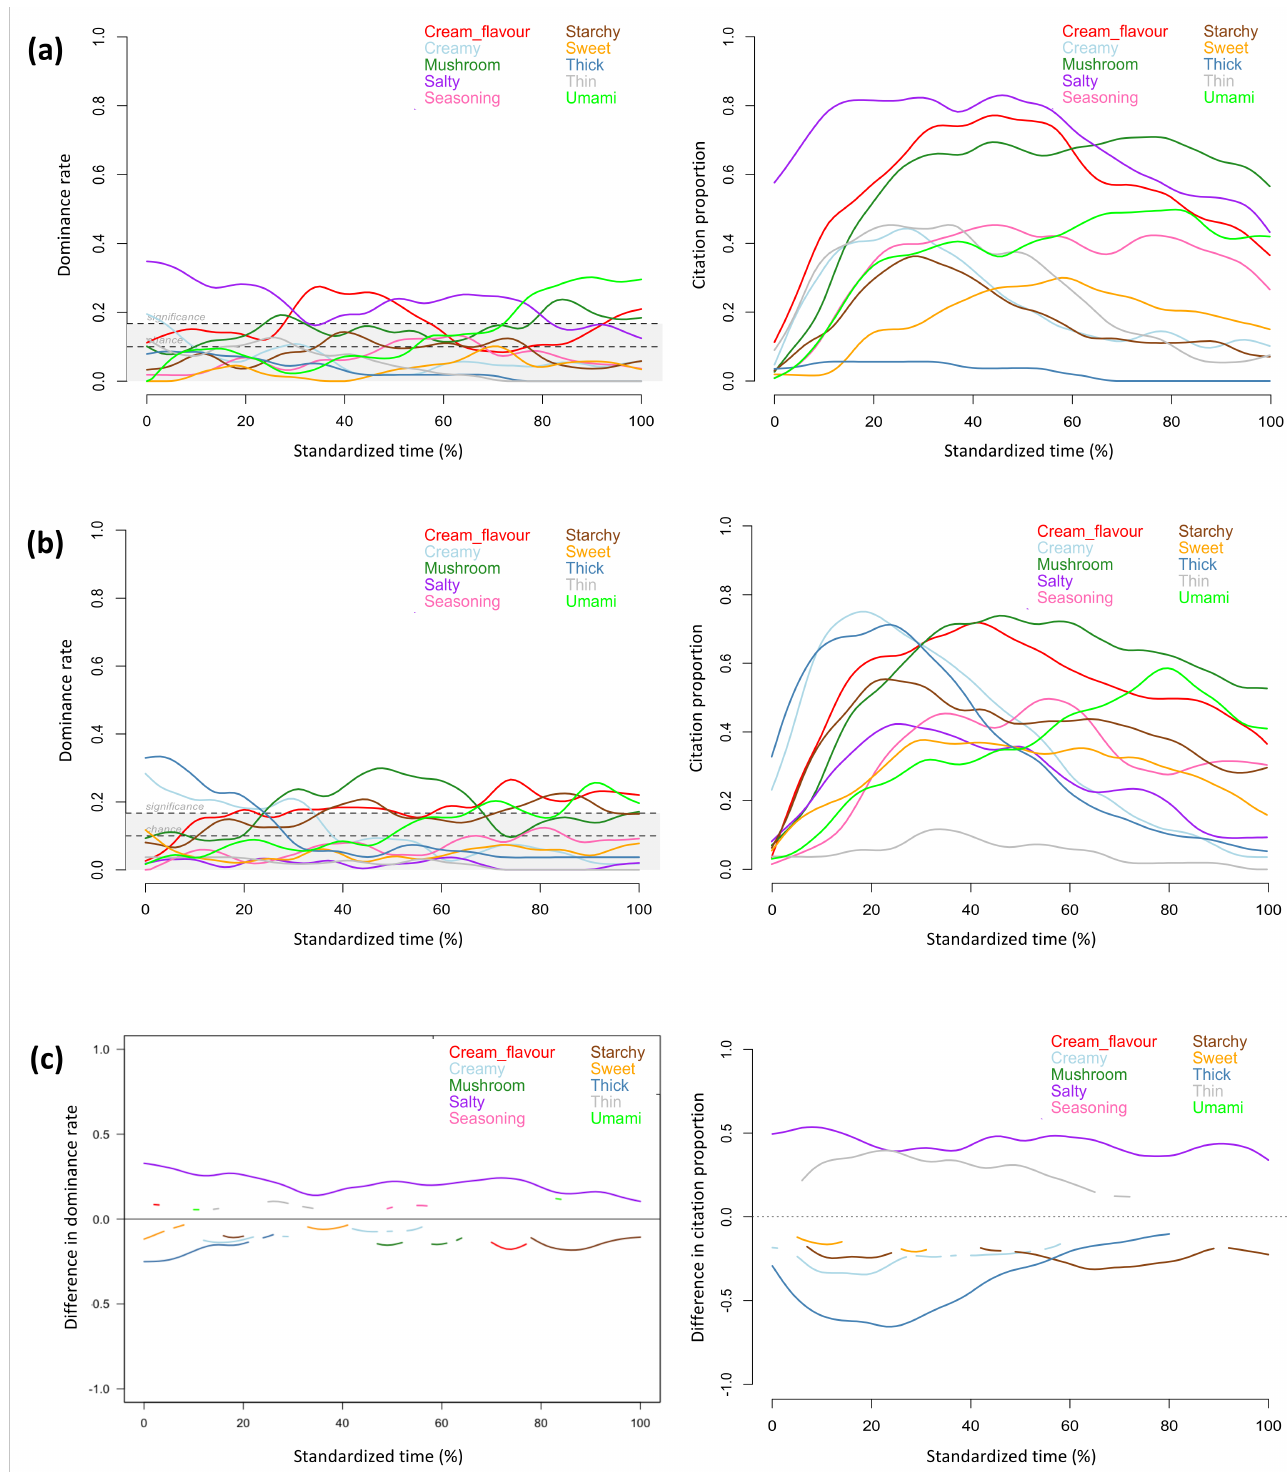
Figure 4. Temporal profiles for regular ( a ) and sodium-reduced ( b ) soup, and significant difference curves ( c ) obtained by TDS (left) and TCATA (right) evaluations of the first intake (n = 54). Aligning with observations of previous studies [22,33,36], TCATA provided more detailed description of concurrent sensory attributes at given timepoints. As only one attribute can be selected as dominant at evaluation time points during TDS evaluation, attribute curves more frequently fluctuated in TDS than TCATA profiles. For the